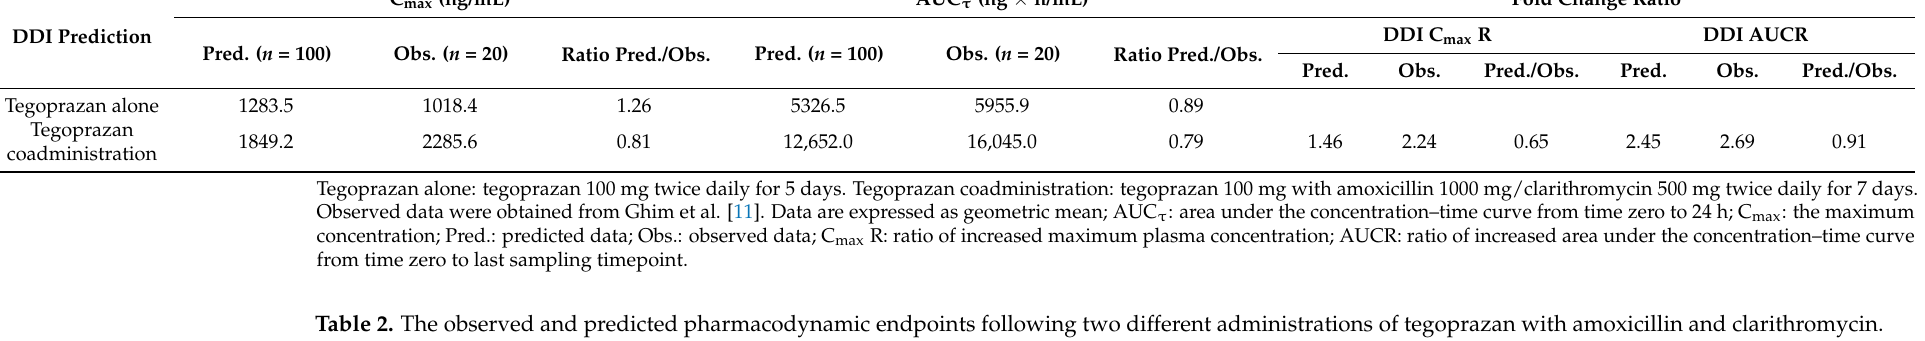
DDI AUCR Pred. Obs. Pred./Obs. Pred. Obs. Pred./Obs.